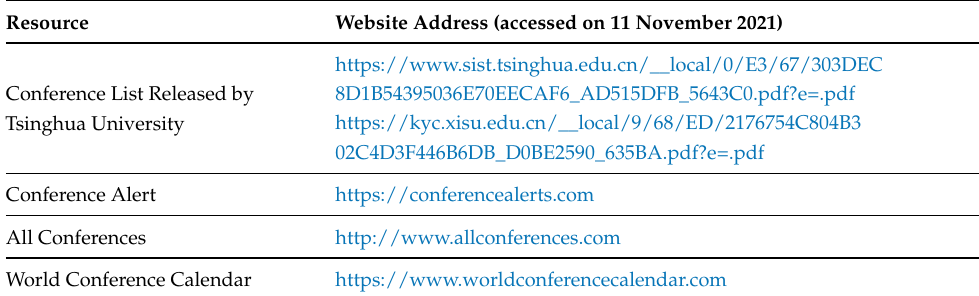
Table A1. Resources for acquiring basic information of academic conferences.